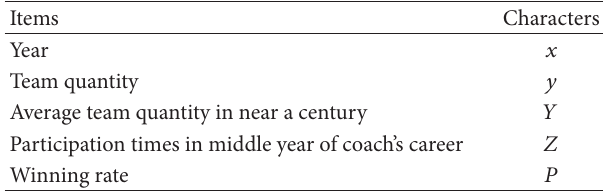
Table 1: Variable definitions mentioned in model 1.